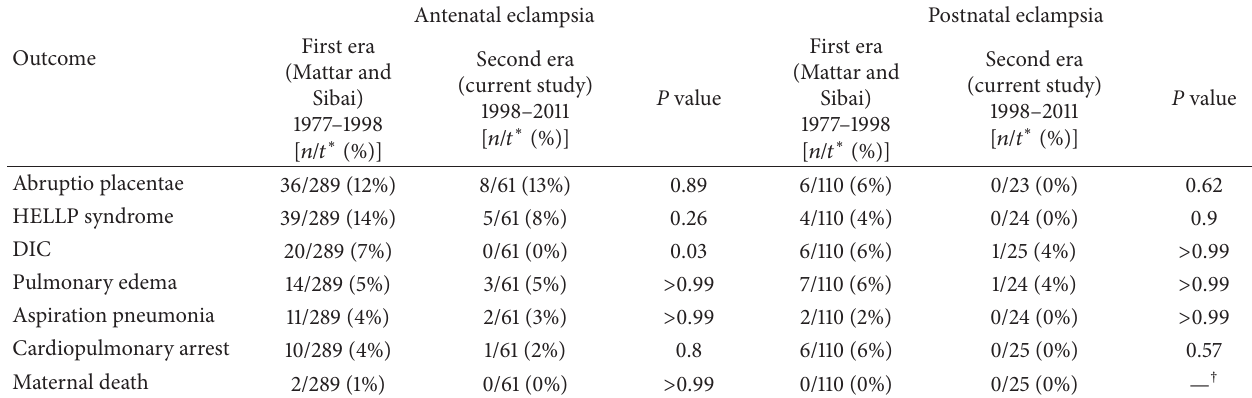
Table 4: Comparison of maternal outcomes of eclampsia cases stratified by